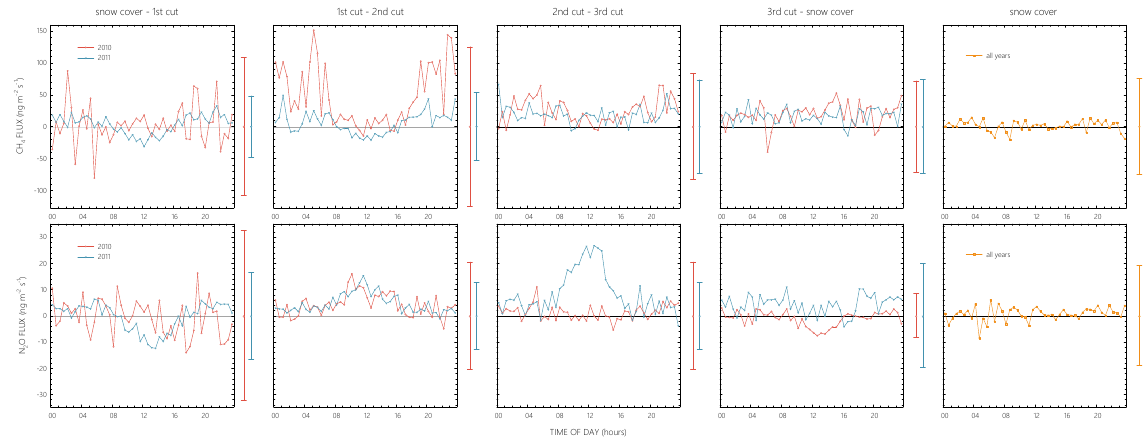
Figure 4. Diurnal cycles of CH 4 and N 2 O fluxes during different time periods in 2010 and 2011. Whiskers to the right of each plot show the average standard deviation during the respective time period. Management data were excluded from the analysis.